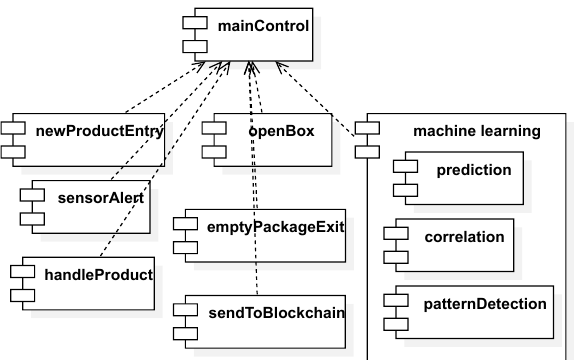
Figure 8. Functionalities of tier 2 in APTM.